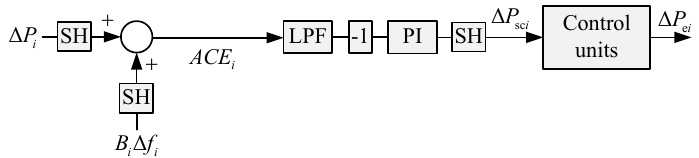
Figure 2. Schematic block diagram representation of the LFC in the CA i .